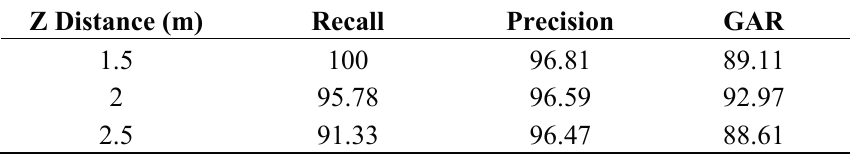
Table 2. Experimental Results based on the Z Distances (unit: %).